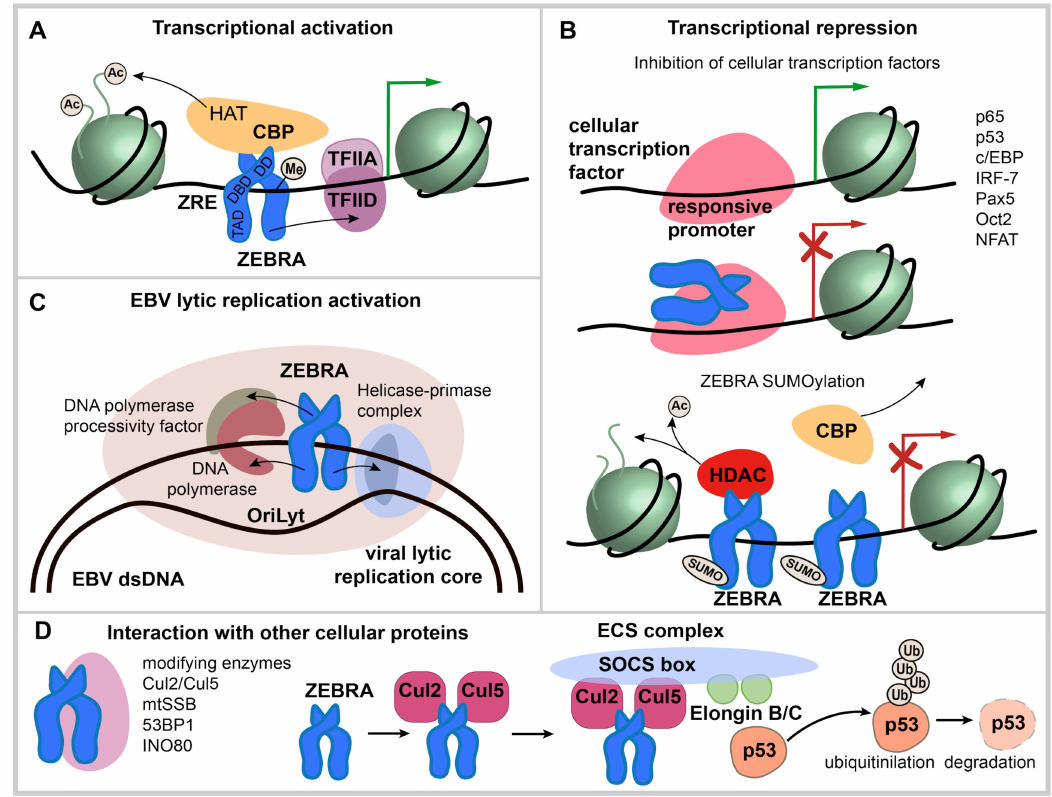
Figure 3. ZEBRA functions. ( A ) transcriptional activation by ZEBRA. ZEBRA is shown as a homodimer, relative positions of transactivation domain (TAD), DNA binding domain (DBD) and dimerization domain (DD) are indicated. ZEBRA binds to specific ZEBRA response elements (ZREs) within promoters of viral and host genes with a preference to methylated-CpG DNA. ZEBRA binding leads to sequential recruitment of basal transcription factors and RNA polymerase II. In addition, ZEBRA binds transcriptional coactivator CREB binding protein (CBP). ( B ) transcriptional repression via ZEBRA binding to cellular transcription factors and by SUMOylated ZEBRA. Transcription factors that interact directly with ZEBRA are listed. The interaction occurs mainly via ZEBRA’s bZIP domain and mutually impedes the function of both ZEBRA and bound transcription factor and results in repression of targeted genes. SUMOylated ZEBRA has a low transactivation activity related to decreased CBP binding and the ability to recruit histone deacetylases (HDAC) to responsive promoters. ( C ) activation of EBV lytic replication. ZEBRA recognizes the EBV lytic origin (oriLyt), serves as the origin binding protein and recruits viral core replication enzymes to initiate lytic replication of EBV. ( D ) interaction with cellular proteins not directly involved in transcriptional regulation. ZEBRA interaction partners are listed. ZEBRA interaction with Cul2 / Cul5 induces the formation of multimolecular ECS complex (Elongin B / C-Cul2 / 5-SOCS-box protein) with the ubiquitin ligase activity that targets p53 for proteasomal